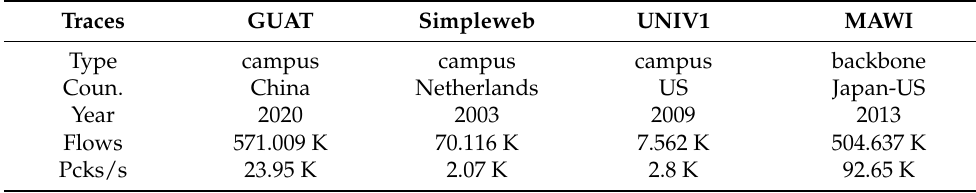
Table 6. Traces (5 min) used for evaluation (MAWI only collect the IPV4 flows.)